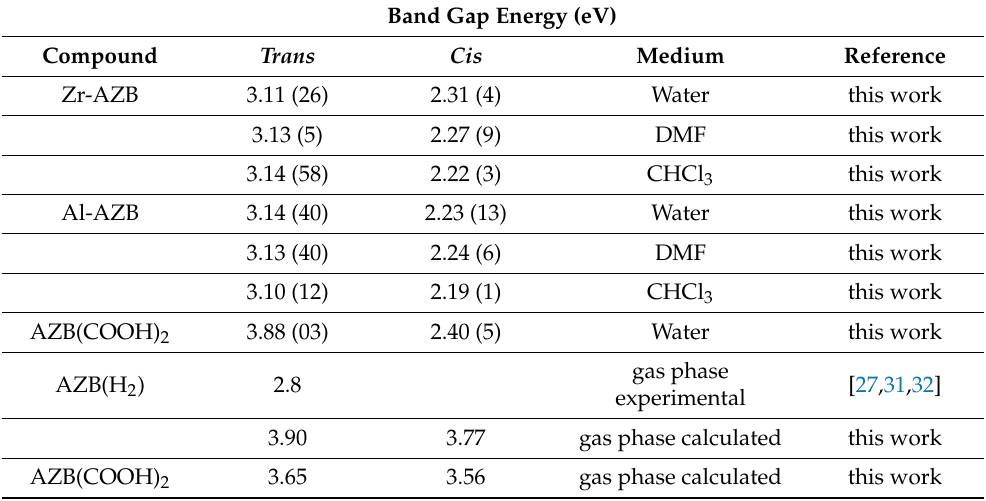
Figure 7. The UV–Vis spectra in water of trans and cis forms of ( a ) Al-AZB and ( b ) Zr-AZB as well as Tauc plots of ( c ) Al-AZB trans isomer, ( d ) Zr-AZB trans , ( e ) Al-AZB cis , and ( f ) Zr-AZB cis . Table 3. Band gap energy obtained for the indicated compounds in different solvents in this study and the